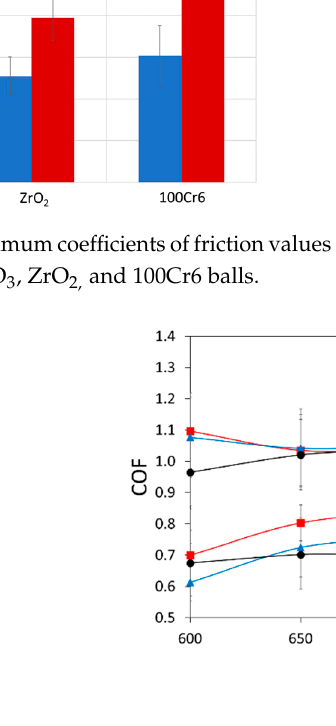
Figure 8. The influence of temperature and the friction couple on the average and maximum coefficients of friction values for Ti-6Al-7Nb after oxidation for 24 h ( a ) and 72 h ( b ).